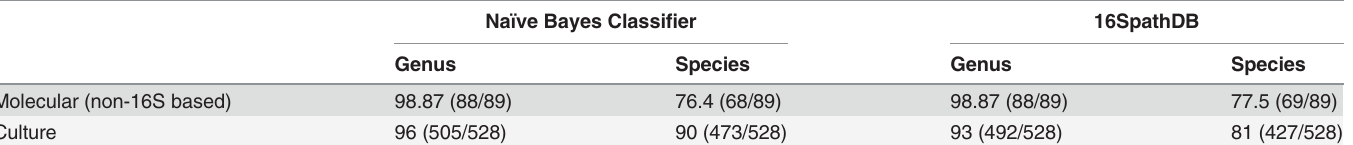
Table 3. Concordance rates between 16S rRNA based and clinical identi fi cation for isolates clinically identi fi ed by culture-based or non-16S based molecular